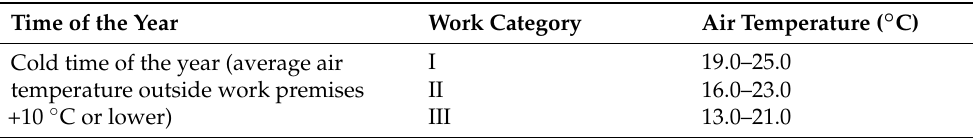
Table 1. Requirements for the Microclimate of Work Premises Depending on Physical Load (Cab.